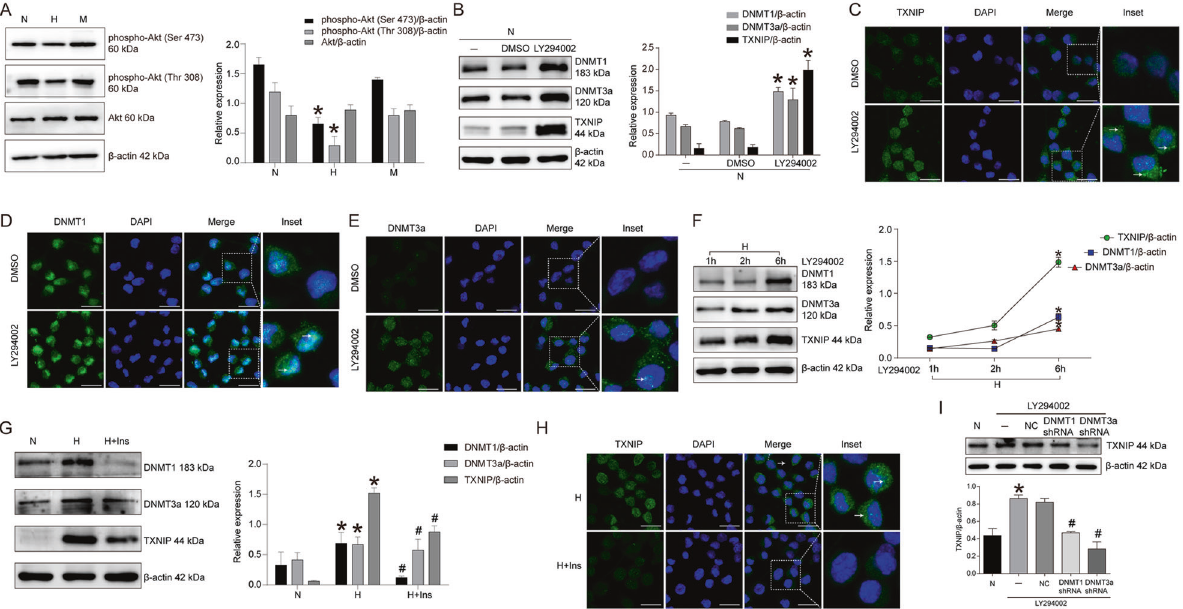
Fig. 6 PI3K/Akt pathway mediated high glucose-induced DNMT1, DNMT3a, and TXNIP upregulation in RSC96 cells. A Western blot of phospho-Akt (Ser 473), phospho-Akt (Thr 308), and Akt and statistical analysis in RSC96 cells treated with normal glucose, high glucose and mannitol. * P < 0.05 versus N group. B Western blot and statistical analysis of DNMT1, DNMT3a, and TXNIP in RSC96 cells treated with LY294002. * P < 0.05 versus DMSO group. C Immuno fl uorescence of TXNIP in RSC96 cells treated with LY294002. The inset was shown with dashed square. White arrows showed positive staining. Bar: 20 μ m. D Immuno fl uorescence of DNMT1 in RSC96 cells treated with LY294002. The inset was shown with dashed square. White arrows showed the positive staining. Bar: 20 μ m. E Immuno fl uorescence of DNMT3a in RSC96 cells treated with LY294002. The inset was shown with dashed square. White arrows showed the positive staining. Bar: 20 μ m. F Western blot and statistical analysis of the time-dependent effect of LY294002 on DNMT1, DNMT3a, and TXNIP in high glucose-cultured RSC96 cells. * P < 0.05 versus 1 h group. G Western blot and statistical analysis of the effect of insulin on DNMT1, DNMT3a, and TXNIP in RSC96 cells. * P < 0.05 versus N group, # means P < 0.05 versus H group. H Immuno fl uorescence of TXNIP expression in high glucose cultured RSC96 cells treated with insulin. The inset was shown with dashed square. White arrows showed the positive staining. Bar: 20 μ m. I Western blot of the effect of DNMT1 and DNMT3a knockdown on TXNIP expression in LY294002-treated RSC96 cells. * P < 0.05 versus N group, # P < 0.05 versus NC